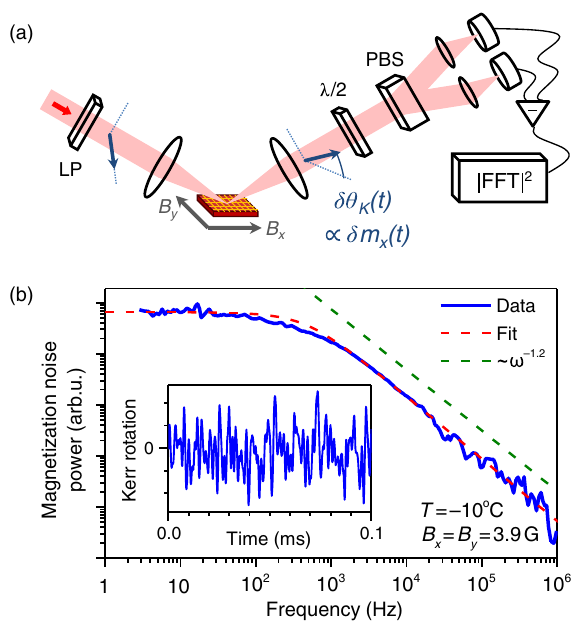
FIG. 2. Optical detection of broadband magnetization noise in ASI. (a) Experimental schematic: A weak probe laser is linearly polarized (LP) and focused on the ASI. Magnetization fluctua- tions of the horizontal islands, δ m x ð t Þ , impart Kerr rotation fluctuations δθ K ð t Þ on the reflected laser, which are detected with a polarization beamsplitter (PBS) and balanced photodiodes. The frequency spectrum of the magnetization noise power, P ð ω Þ — equivalent to the Fourier transform of the temporal magnetization correlation function h δ m x ð 0 Þ δ m x ð t Þi — is computed and averaged in real time. (b) Example of characteristic magnetization noise from square thermal ASI in the time domain (inset), and in the corresponding frequency domain spanning nearly 6 orders of magnitude from 1 Hz to 1 MHz. The dashed red line shows a fit to the model described in the main text, and the dashed green line shows that the noise decays as a power law at high frequencies, in this case as P ∼ ω − 1 . 2 , which indicates correlated and subdiffu- sive